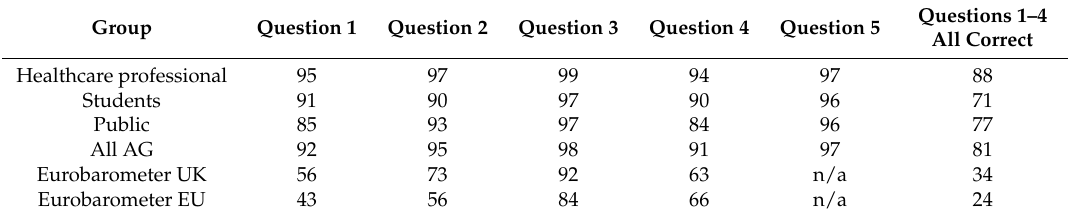
Table 5. Percentage of correct answers to the AMR knowledge questions by pledge group and compared to